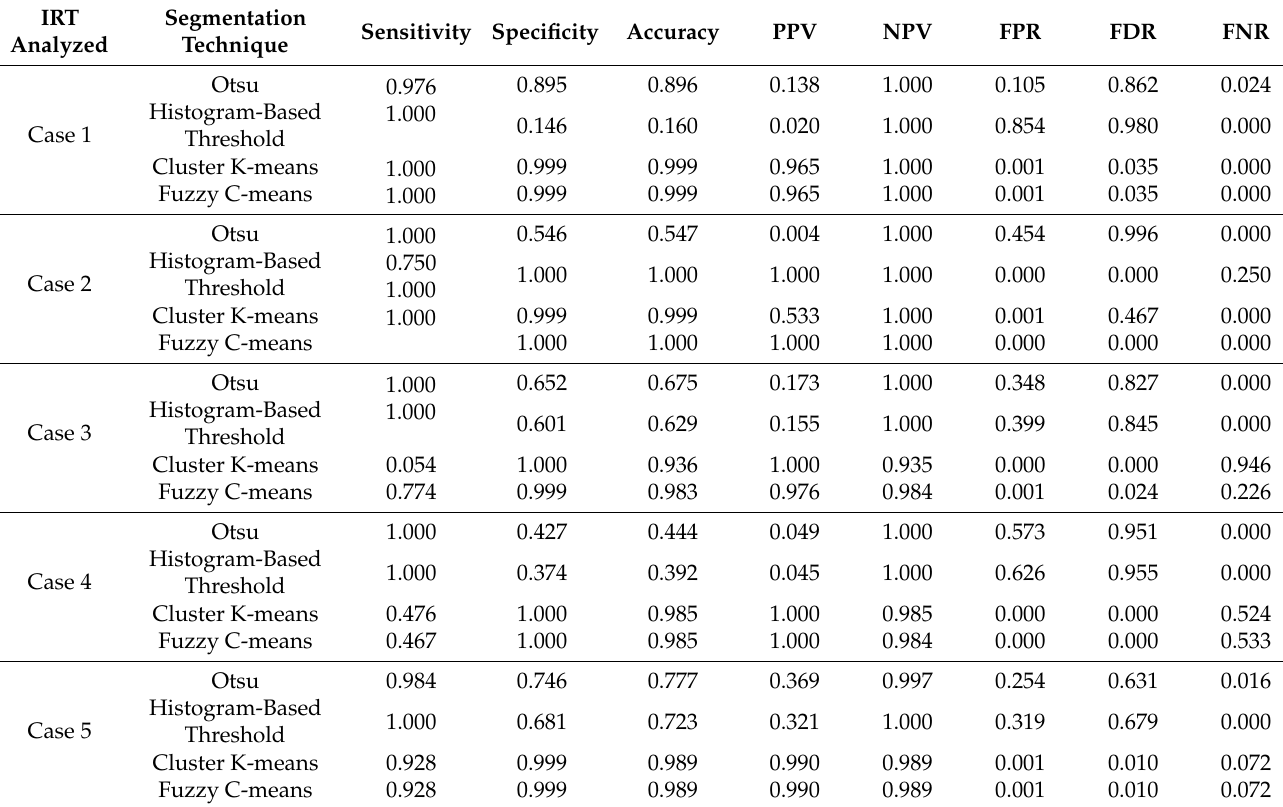
Table 4. Results of the eight statistical measures of performance of the four IRT image segmentation methods of the analyzed